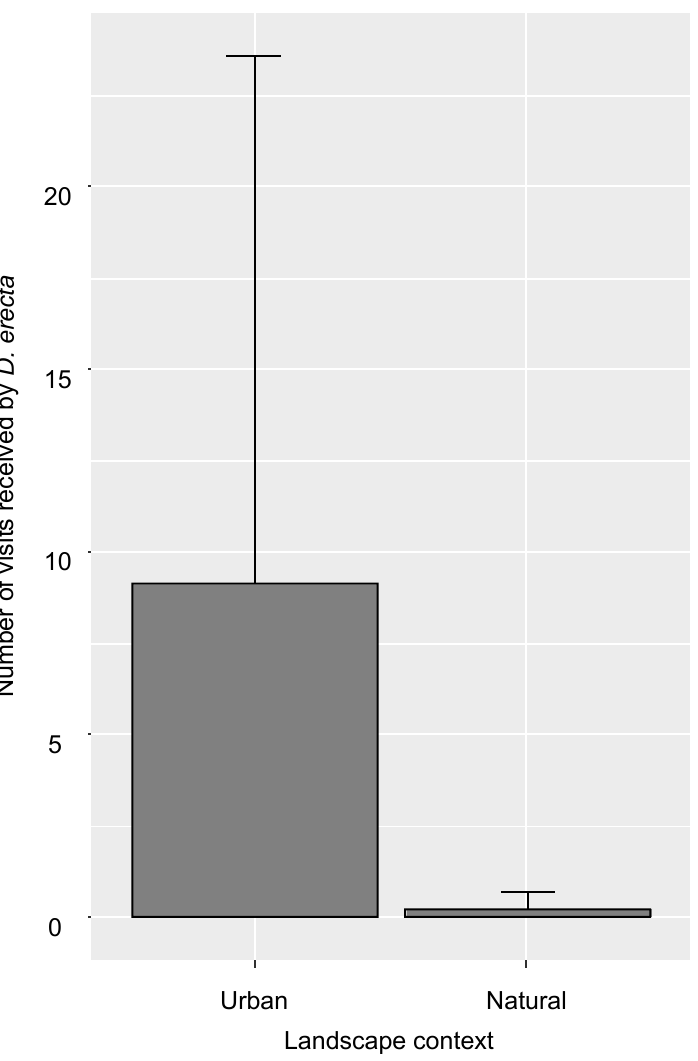
Figure 2. Mean ( ± SD) number of visits received by D. erecta in the urban context and the natural context.